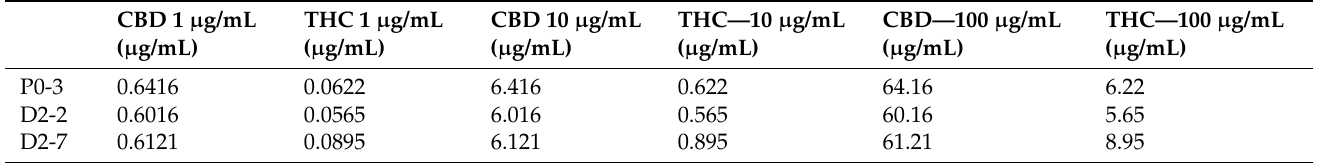
Table 2. Amount of CBD and THC content in every plant extract tested (P0-3, D2-2, and D2-7), at three different concentrations of whole extract (1 µ g/mL, 10 µ g/mL, and 100 µ